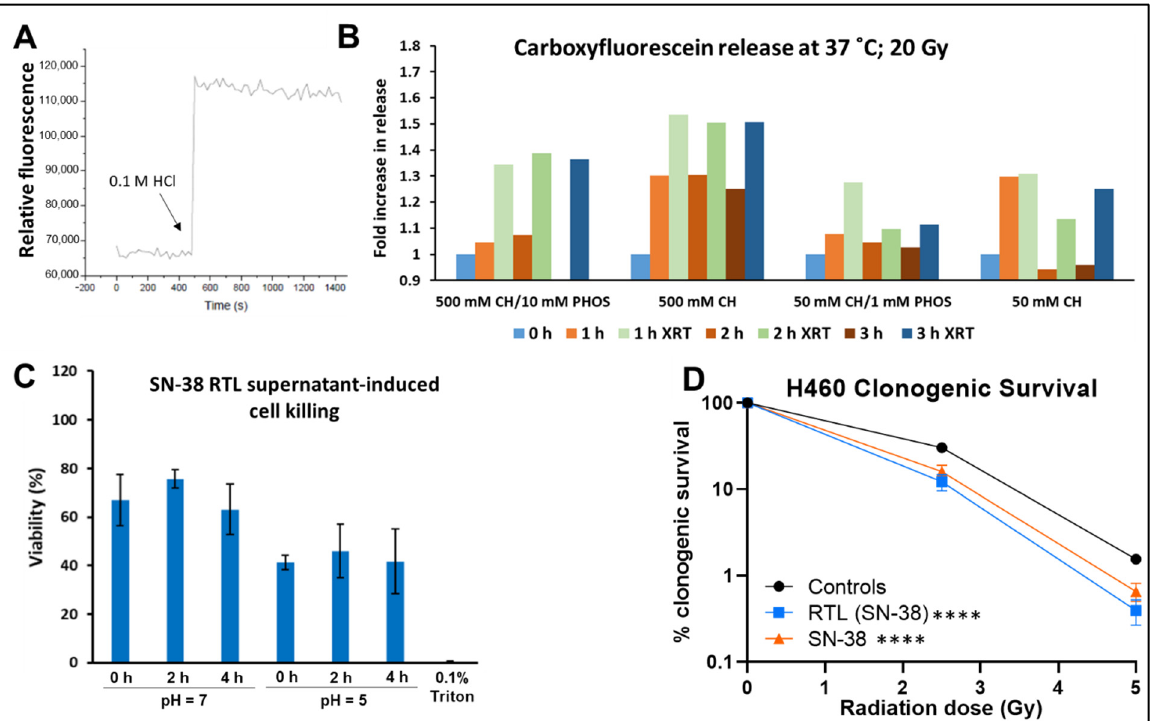
Figure 2. Characterization of in vitro RTL release. ( A ) Demonstration of the pH dependent release trigger as measured by carboxyfluorescein release from RTLs upon acidification with 70 µ L of 0.1 M HCl to a final pH of 5.7–5.9. ( B ) Carboxyfluorescein release from RTLs formulated with varying concentrations of chloral hydrate (CH; 50 mM or 500 mM) and phosphate buffer (1 mM or 10 mM) over 3 h of incubation alone or after 20 Gy irradiaton. Data representative of a single experiment. ( C ) Cell viability after exposure to supernatant after incubation of SN-38 loaded RTLs at 37 ◦ C in neutral or acidic pH. Liposomes were incubated in different pH buffers and then supernatant added to the LLC tumor cells. ( D ) Clonogenic survival after incubating cells with SN-38 loaded liposomes or SN-38 alone for 4 h before exposure to 2.5 or 5 Gy of radiation. The drug/liposomes were rinsed off after radiation and replaced with fresh culture medium to allow for surviving cells to form colonies. Average of 3 independent experiments with the bars showing the SD of the mean. Two-way ANOVA with repeated measures for comparison of drug treatments plus radiation vs. radiation alone (**** p <